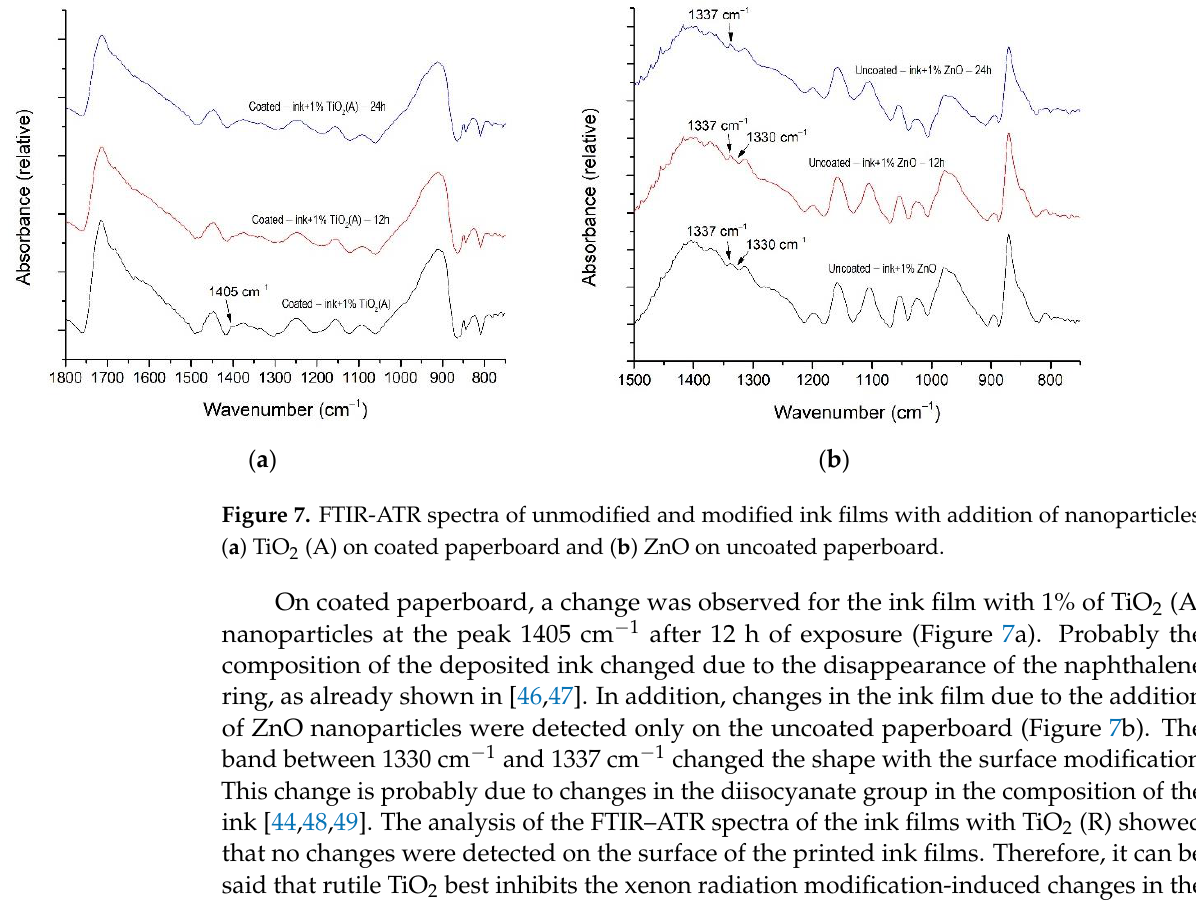
Figure 6. FTIR – ATR spectra of unmodified and modified samples; ( a ) coated paperboard and ( b ) printed ink on the coated paperboard without nanoparticles.